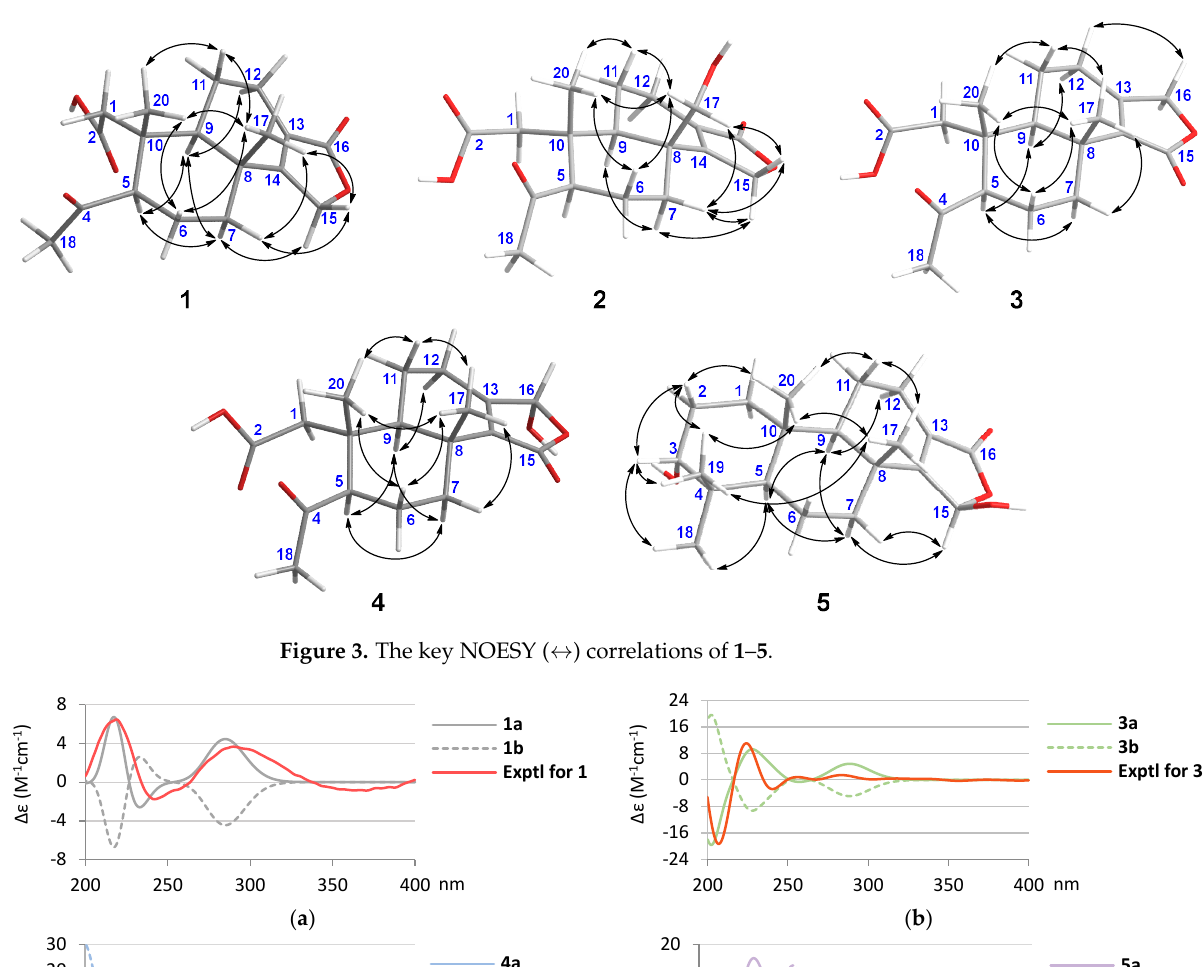
Figure 2. The selected COSY ( ▬ ) and HMBC ( → ) correlations of 1 – 5 .